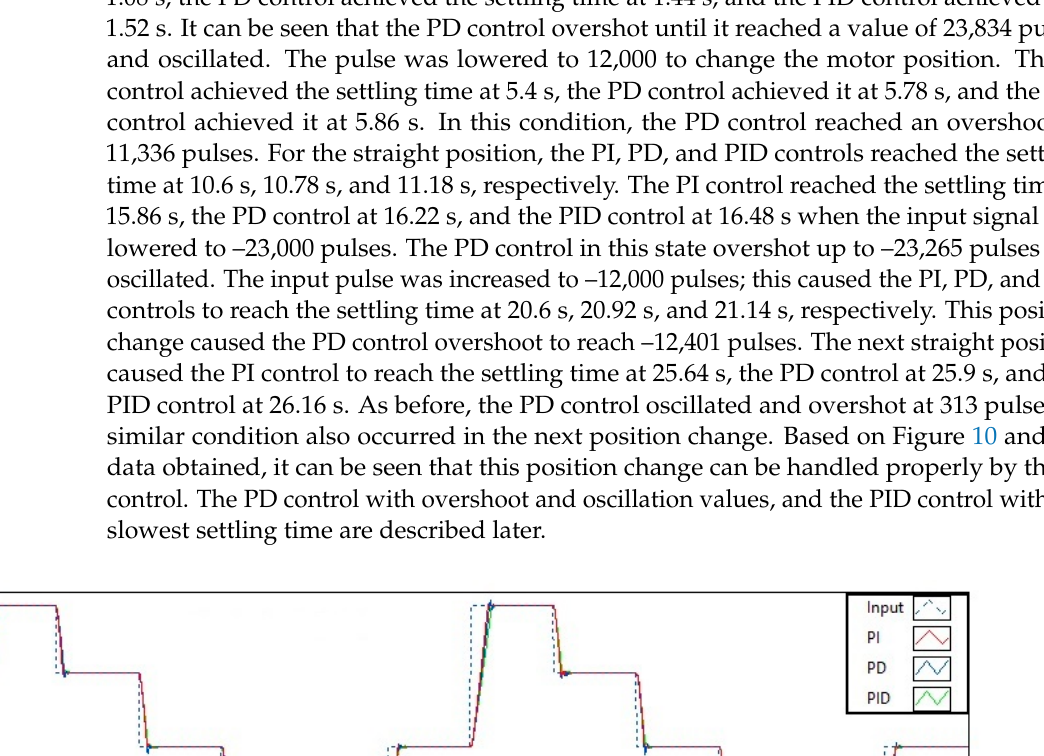
14 of 22 Figure 9. Result of motor control system. ( a ) Oscillation output; ( b ) PI; ( c ) PD; and ( d ) PID. A trial of several positions of the EPS motor was carried out to test the secondary control. Following the design, the steering angle of this vehicle was 35 degrees for both the left and right directions, which was converted to 23,000 pulses. There were five out- puts—turning more to the left (big left = –23,000 pulses), turning little to the left (small left